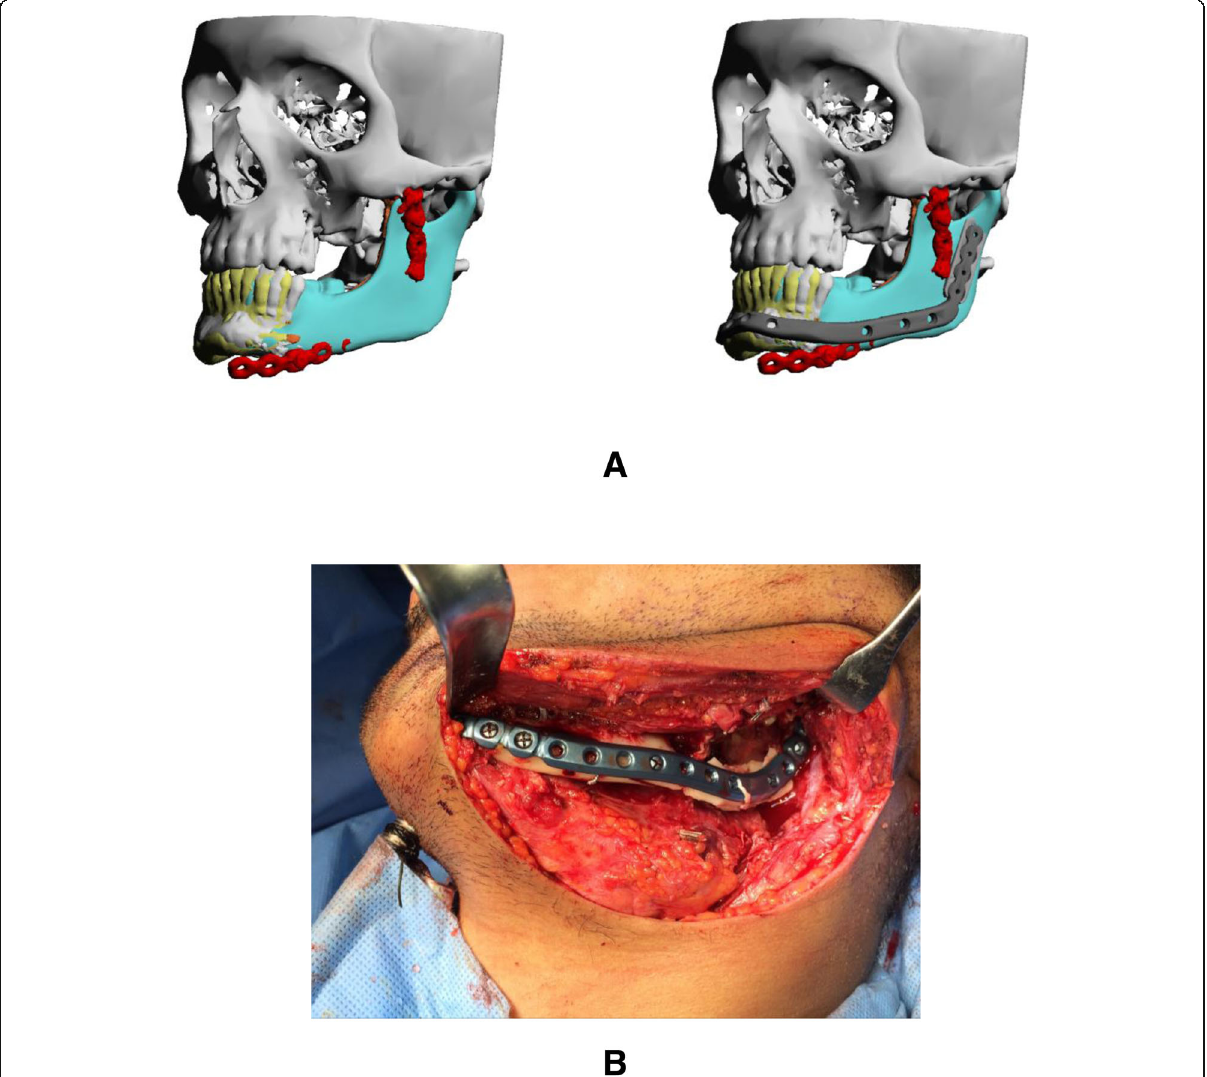
Fig. 6 Post-free flap reconstruction case. a 3D reconstruction of CT showing previous plate and planned custom titanium implant.